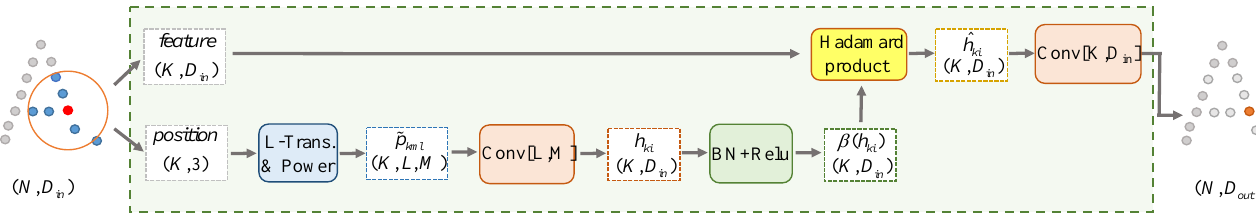
Figure 2. ( a ) Pipeline of PSConv. We first linearly transform local points and then compute their high-order powers to learn filters, which are utilized to conduct convolution on point features. Conv [ L , M ] means convolution with filter width, height as L , M . ( b ) Framework of PSNet. It is a hierarchical architecture with MLP, max-pooling, PSConv and point sampling as basic components. Please refer to Section 3 for details.